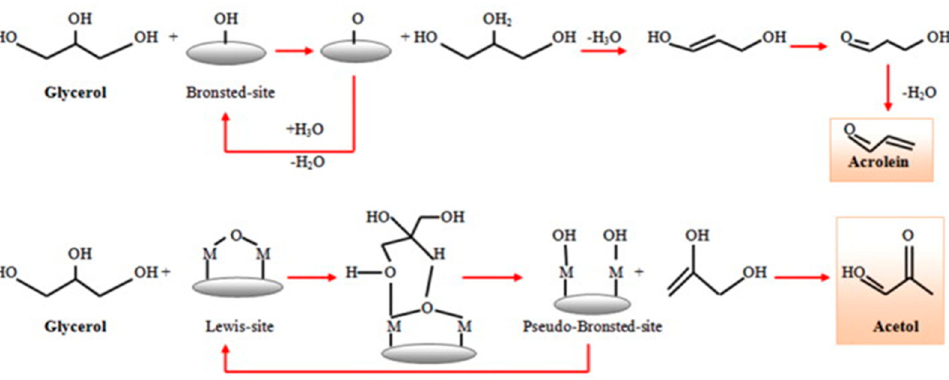
Figure 21. Catalytic glycerol dehydration over Brønsted and Lewis acid sites (adapted from [191